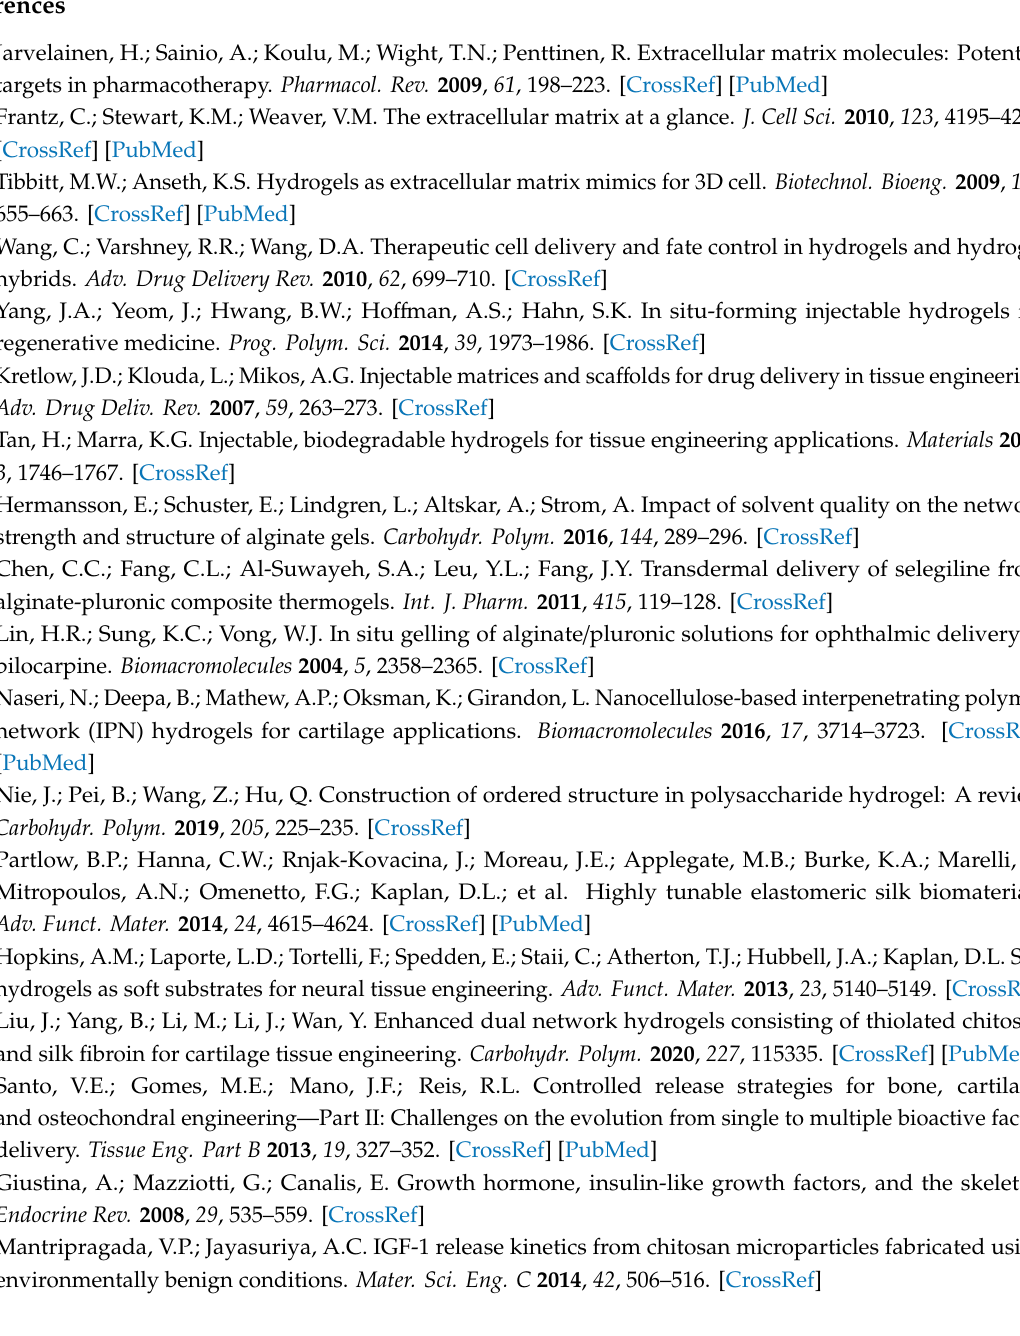
Figure S1. 1 H NMR spectra for monoamine-terminated poloxamer (MATP). Figure S2. FTIR spectra for poloxamer (A), alginate (B) and alginate-poloxamer (C). Figure S3. ALG-POL fluids and formed ALG-POL gel after incubation. (Concentration of ALG-POL: 9 wt% (A); and 12 wt%